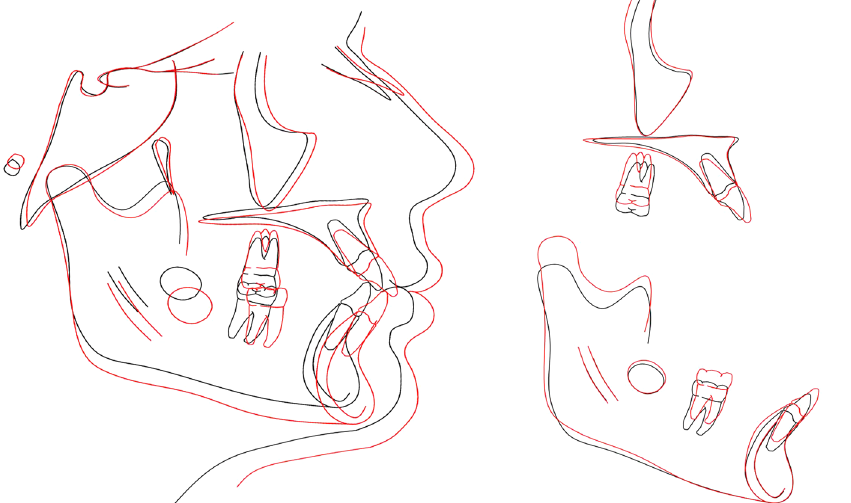
Figure 13. Superimpositions of pre-treatment cephalograph (Black) and post-treatment cephalograph (Red) over anterior cranial base (left) and anterior surface of maxilla (upper right) and stable structures of mandible (lower right) as per Bjork’s structural